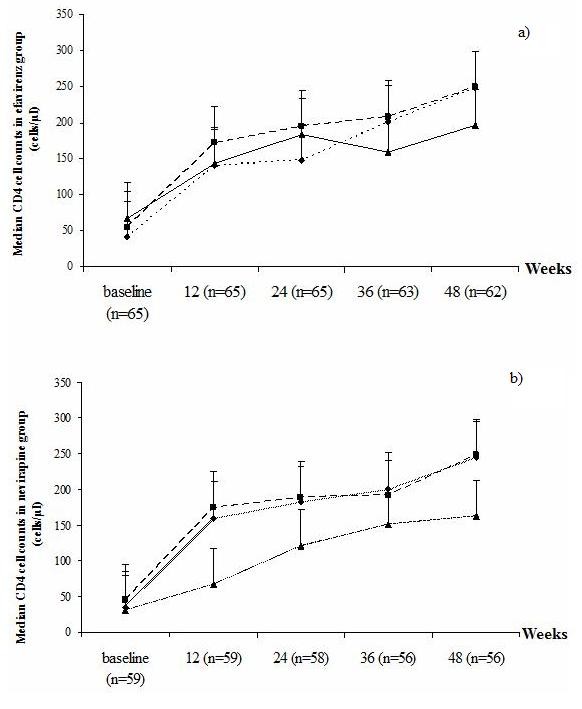
Median CD4 T cell counts among HIV/TB adults with CYP2B6-G516T polymorphism at different time points. (Black diamond) GG genotype, (Black square), GT genotype, (Black triangle) TT genotype in efavirenz (a) and nevirapine groups (b) at baseline, 12, 24, 36 and 48 weeks of ART.